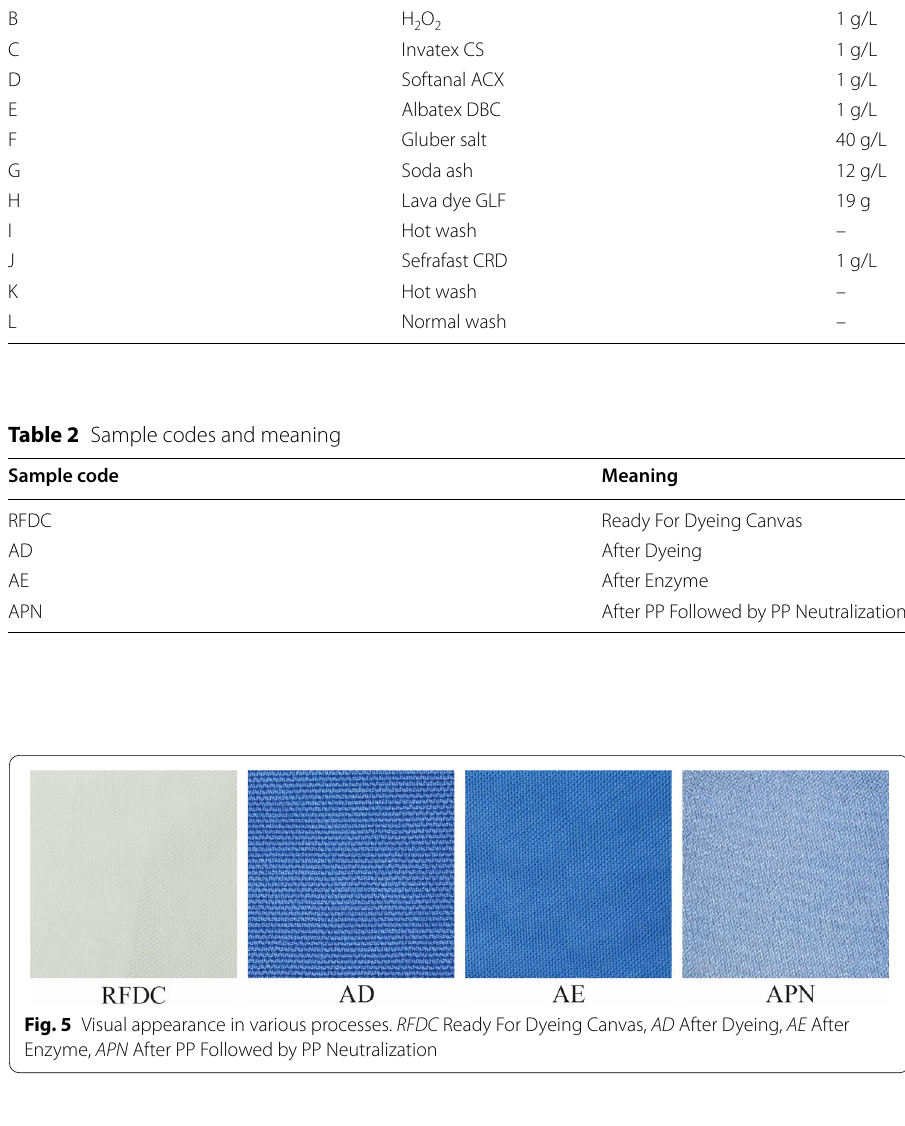
Color fastness to rubbing Surface fiber and unfix dye may be crocked out from the fabric surface during the rub-